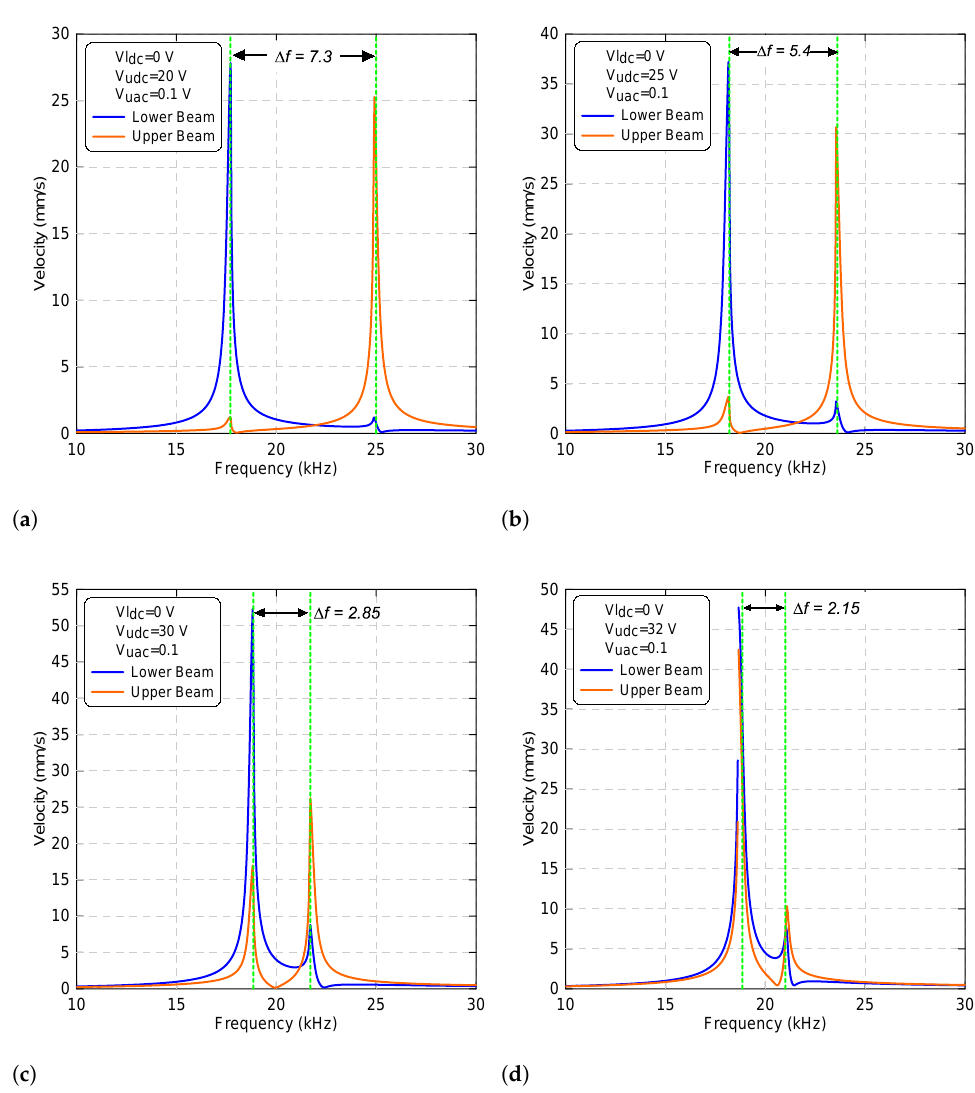
Figure 10. The frequency-response curves of the lower beam resonance frequency f l 1 and of the upper beam resonance frequency f u 1 with a lower voltage set to V ldc = 0 V and an upper voltage set to: ( a ) V udc = 20 V, ( b ) V udc = 25 V, ( c ) V udc = 30 V and ( d ) V udc = 32 V. The upper harmonic voltage V uac is set to 0.1 V. The lower beam results are marked with blue lines and the upper beam results are marked with orange